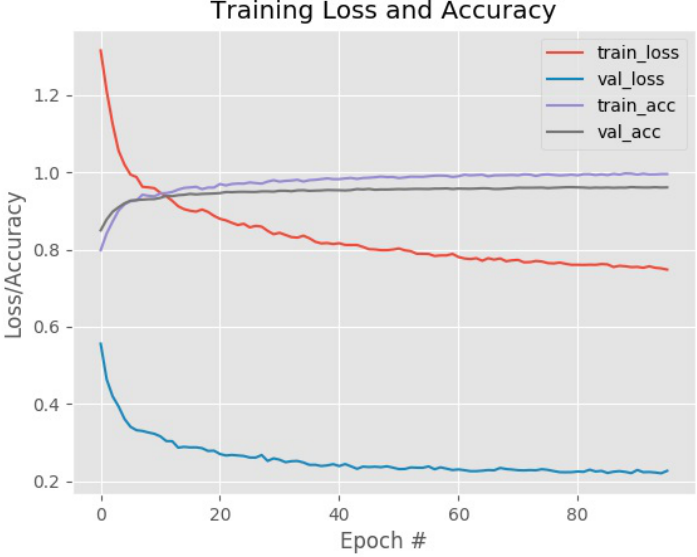
Figure 11. Training plot of the proposed method with 20% of AID dataset as the training set for Xception, cyclical learning rate, and softmax classifier.